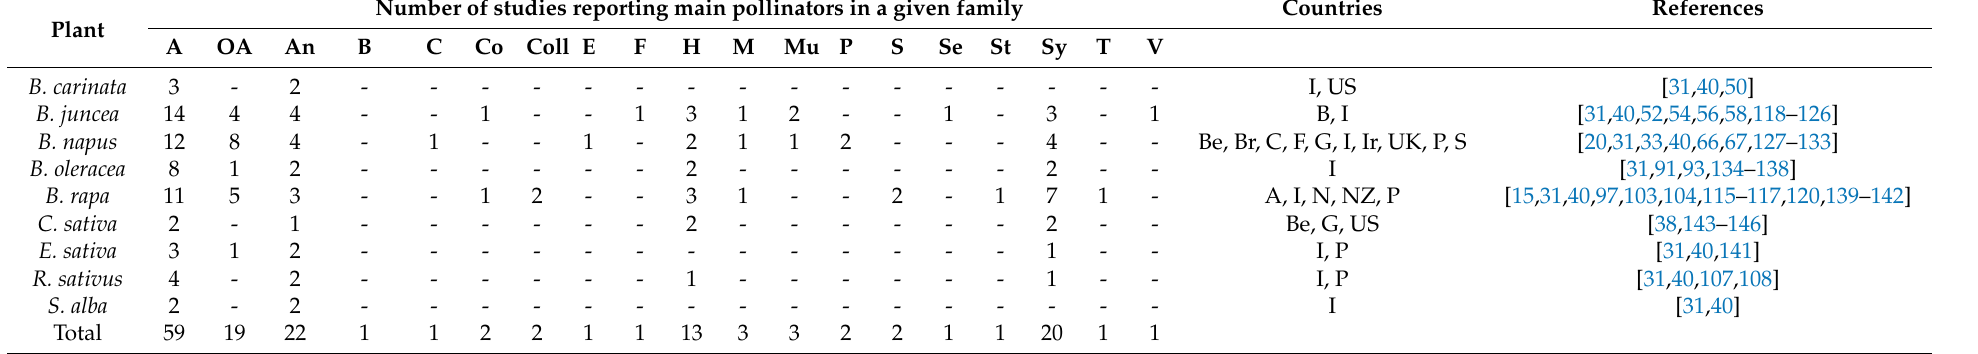
Table 4. Insect pollinators of crops of the family Brassicaceae. Abbreviations for pollinators are as follows: Apidae of the genus Apis (A), other Apidae different than Apis spp. (OA), Andrenidae (An), Bibionidae (B), Calliphoridae (C), Coccinellidae (Co), Colletidae (Col), Empididae (E), Formicidae (F), Halictidae (H), Megachillidae (M), Muscidae (Mu), Pieridae (P), Scarabaeidae (S), Sepsidae (Se), Stratiomyidae (St), Syrphidae (Sy), Tabanidae (T), and Vespidae (V). Abbreviations for countries are as follows: Australia (A), Bangladesh (B), Belgium (Be), Brazil (Br), China (C), France (F), Germany (G), India (I), Ireland (Ir), Nepal (N), New Zealand (NZ), Pakistan (P), Sweden (S), United Kingdom (UK), and United States of America (US). Number of studies reporting main pollinators in a given